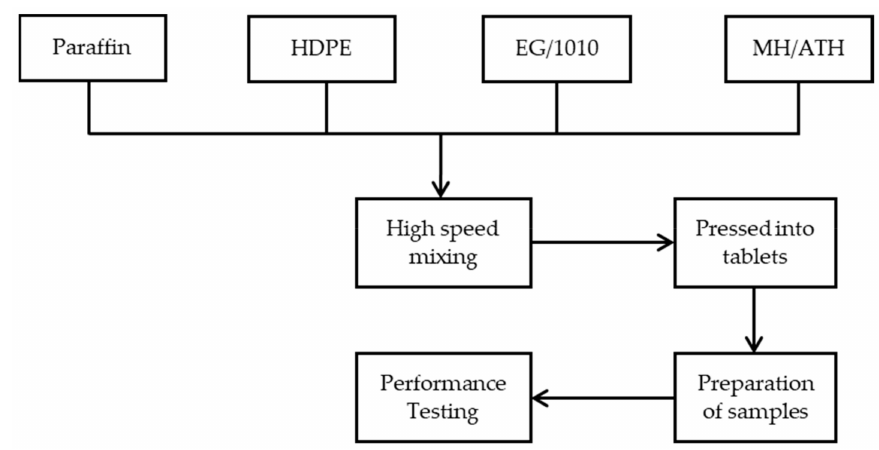
Figure 1. Preparation process diagram of the phase change materials